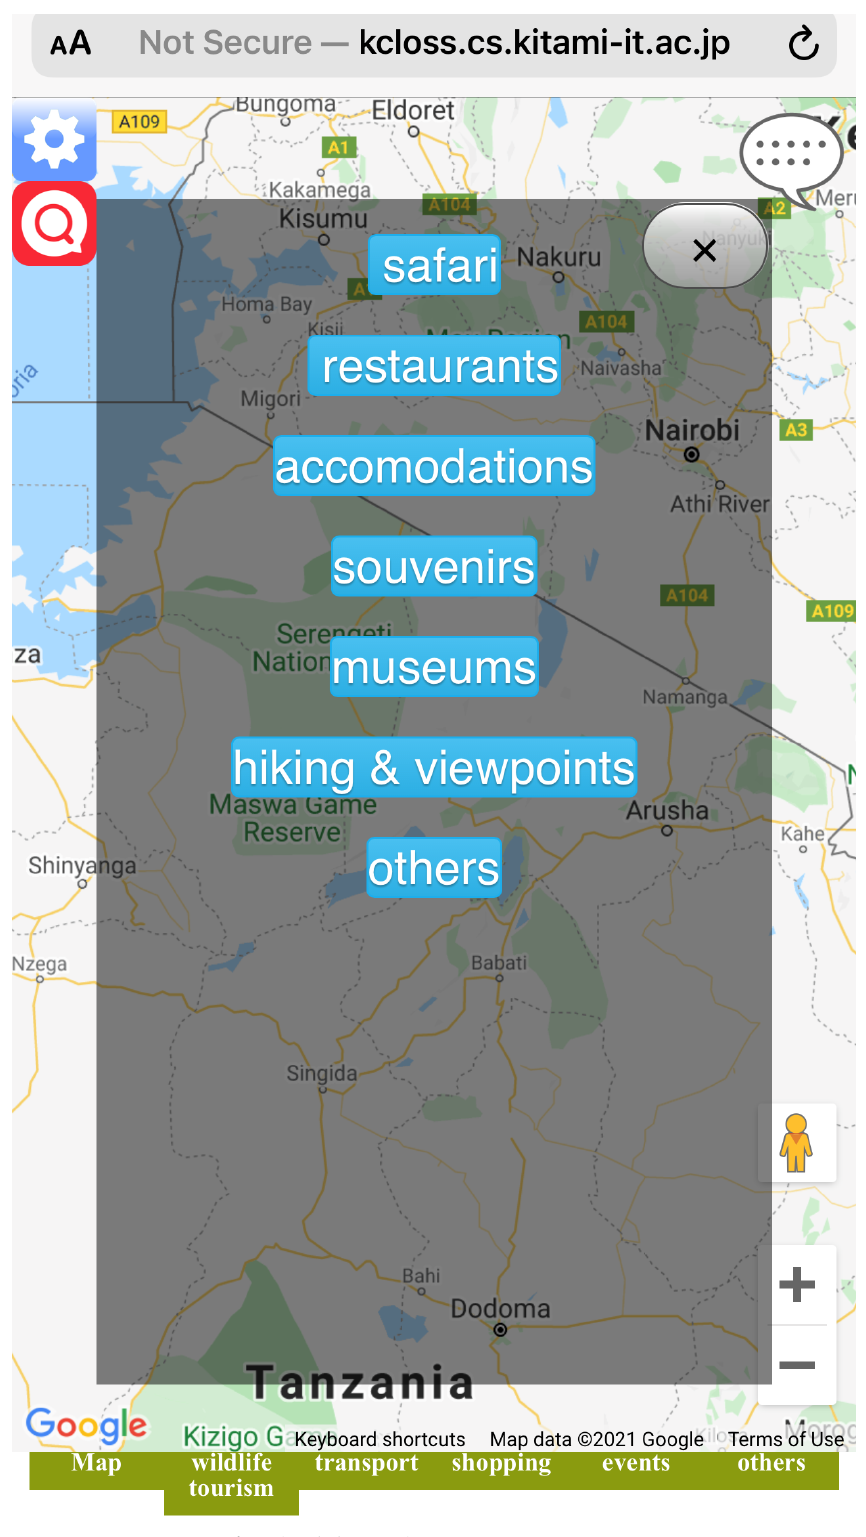
Figure 9. System interface (mobile